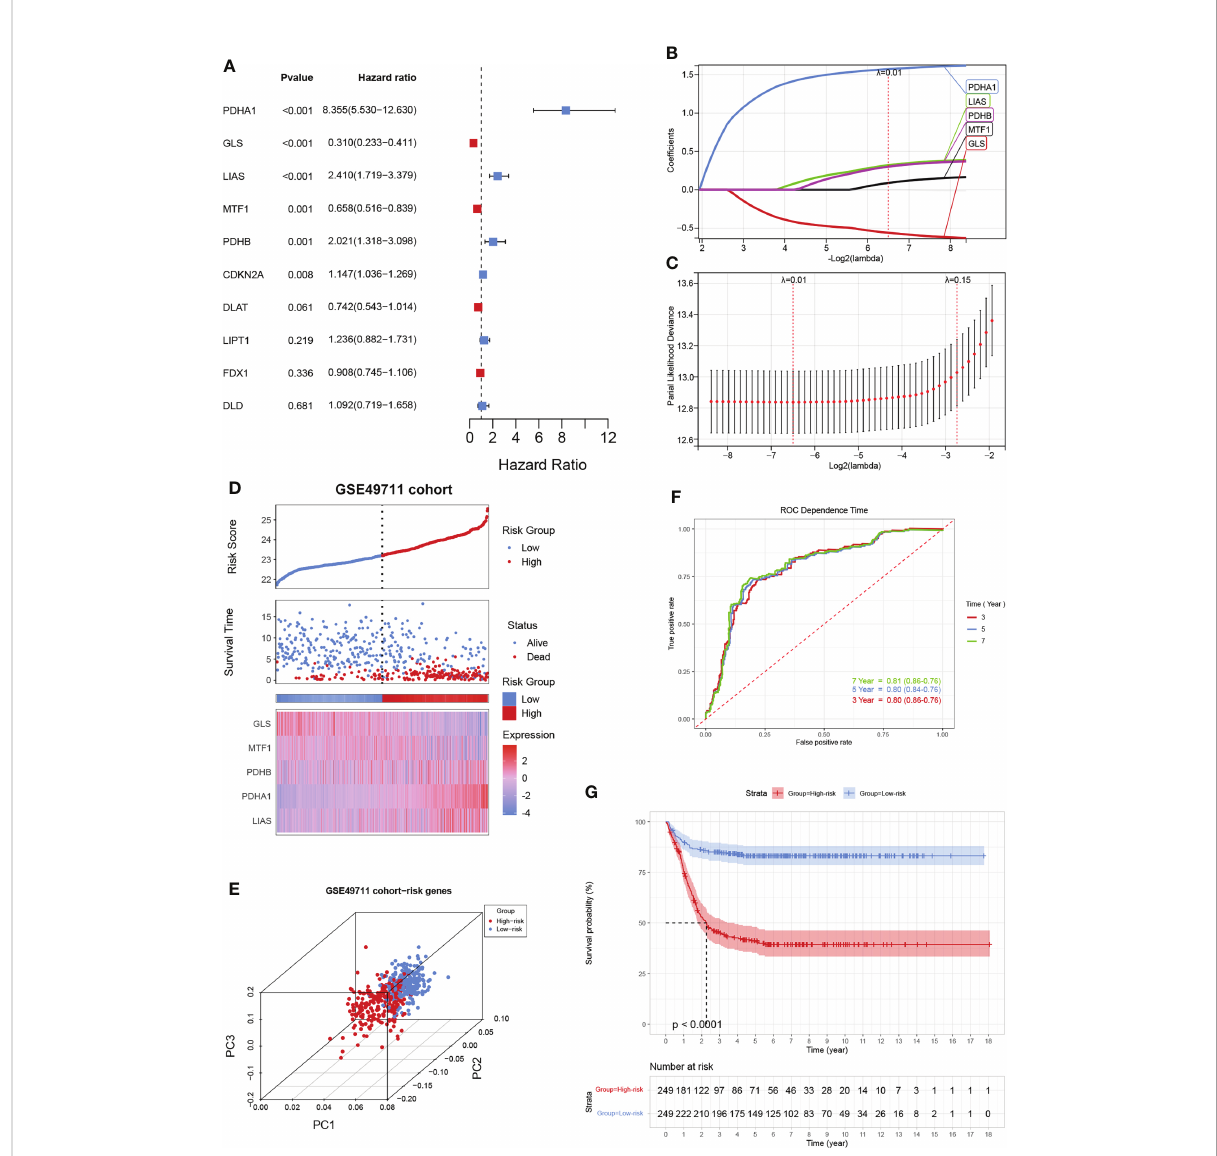
FIGURE 3 Construction of a cuproptosis-related gene signature in the training cohort. (A) The forest map shows six genes signi fi cantly correlated with progression-free survival in the univariable Cox regression analysis. (B) The trajectory of each independent variable. The horizontal axis represents the log value of the independent lambda, and the vertical axis represents the coef fi cient of the independent variable. (C) Partial likelihood deviance of variables revealed by the Lasso regression model. The red dots represented the partial likelihood of deviance values, the gray lines represented the standard error (SE), and the two vertical dotted lines on the left and right represented optimal values by minimum criteria and 1-SE criteria, respectively. (D) Distribution of the riskscore, the associated survival data, and the mRNA expression heatmap of the gene signature in the GSE49711 cohort. Patients were divided into high-risk (red) and low-risk (blue) groups and the median risk score was utilized as the cutoff value. (E) PCA revealed a clear separation between the high- and low-risk subgroups, based on the expression of these 5 risk genes. (F) The time-dependent ROC curves were applied to assess the predictive performance of the cuproptosis-related gene signature, in 3-, 5-, and 7-year survival. (G) Patients in the high-risk subgroup exhibited worse survival compared to those in the low-risk subgroup in the GSE49711